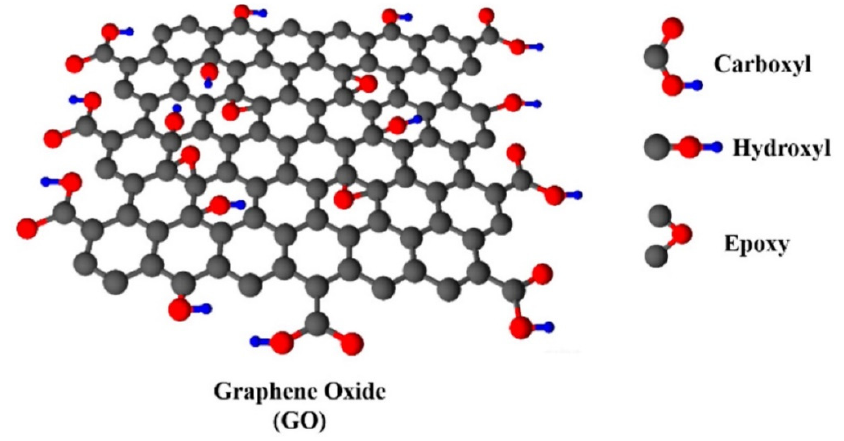
Figure 4. Structure of GO [54].